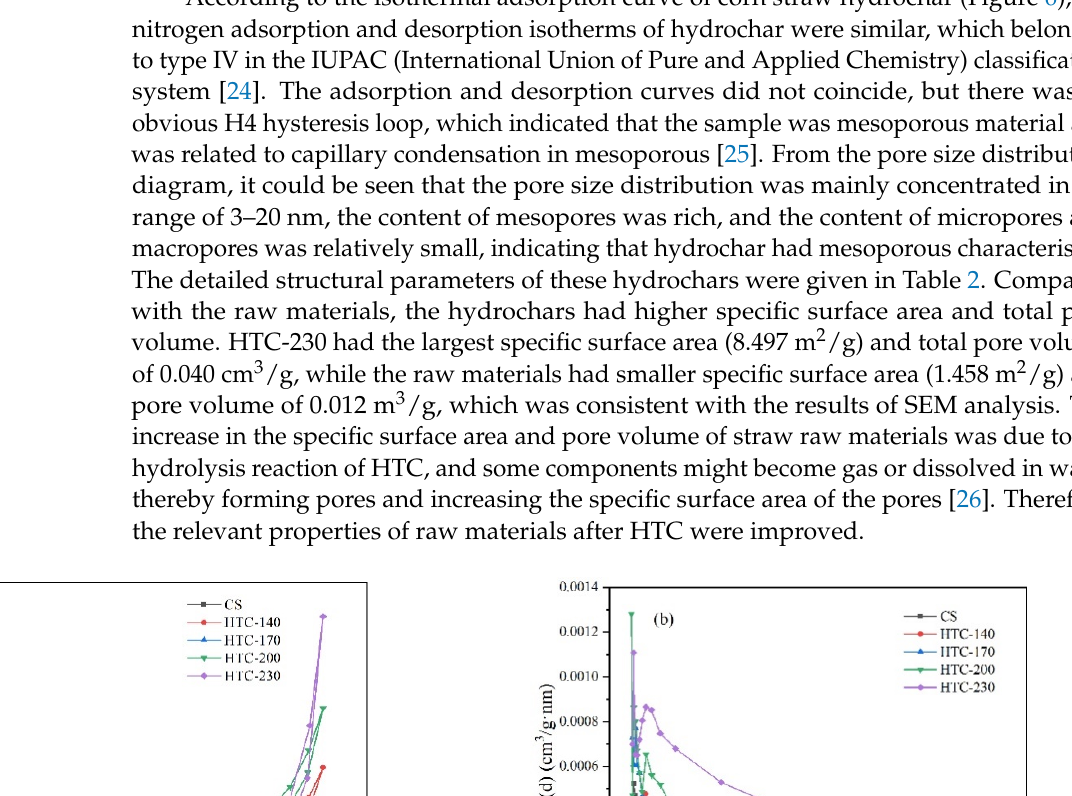
Figure 5. FTIR spectra of CS and hydrochar at different temperatures.